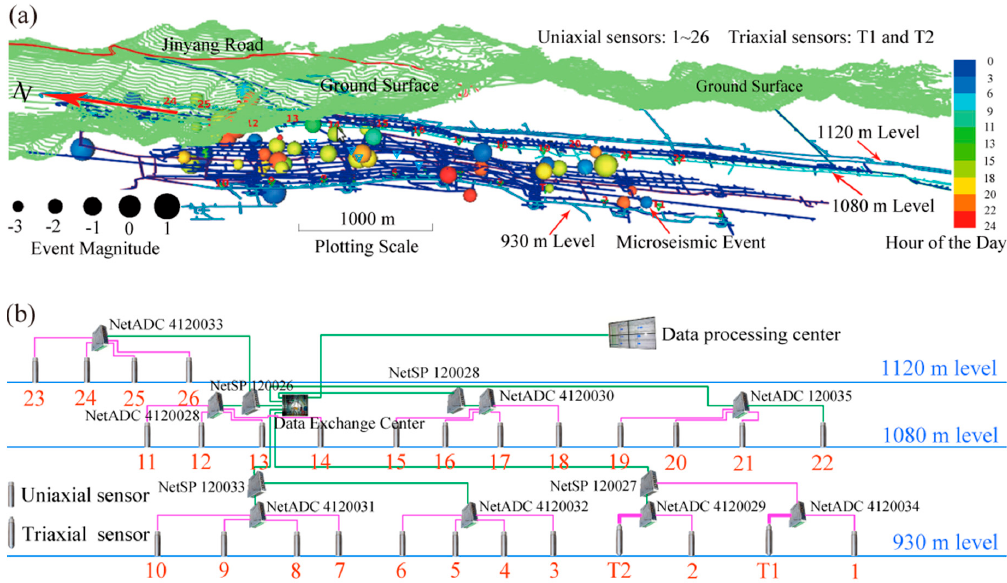
Figure 3. Microseismic monitoring model and system structure diagram of the microseismic (MS) system installed at the Yongshaba mine. ( a ) Microseismic monitoring model modified from Li et al. [52]. The red fonts correspond to the sensor id, green grid means the ground surface, dark orange line is the Jinyang road, blue lines are different mining levels, and light blue lines are the mining levels with sensor distributed. The spheres are locations of microseismic events; ( b ) System structure diagram of the MS system modified from Shang et al. [53]. The green line represents 4 core optical fiber, pink line represents 4 core signal cable, and the bold pink line represents 8 core signal cable.